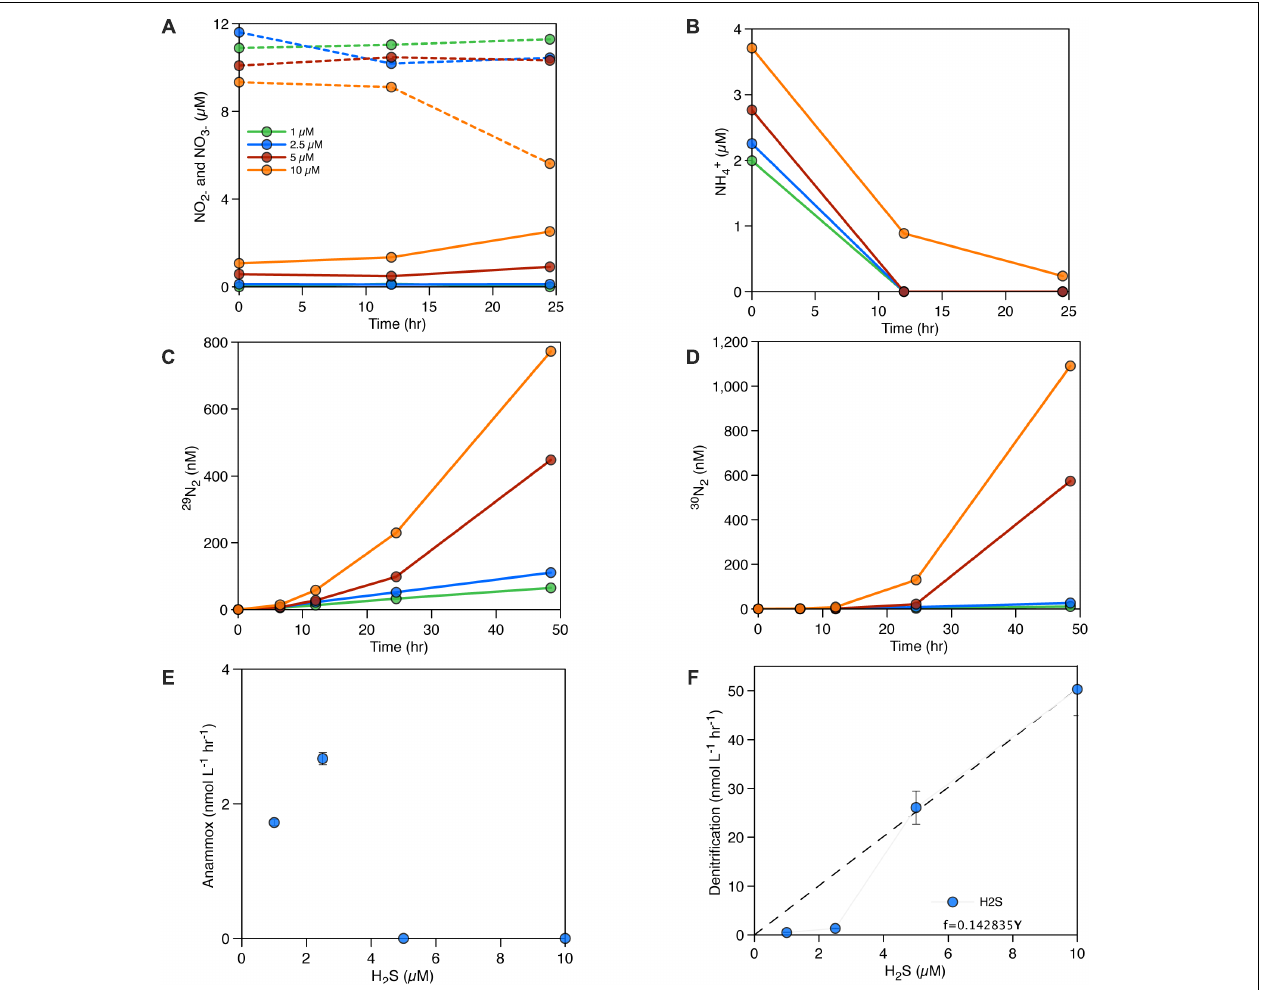
FIGURE 5 | (A) NOx accumulation/consumption over time with the addition of different HS − concentrations – NO 3 − concentrations in dashed lines, NO 2 − concentrations in solid lines. (B) NH 4 + accumulation/consumption over time with the addition of different HS − concentrations. (C) Production of 29 N 2 in the incubations (nM). (D) Production of 30 N 2 in the incubations (nM), (E) measured anammox rates (nM hr − 1 ) for different HS − concentrations in June 2015, (F) measured denitrification rates (nM hr − 1 ) for different HS − concentrations in June